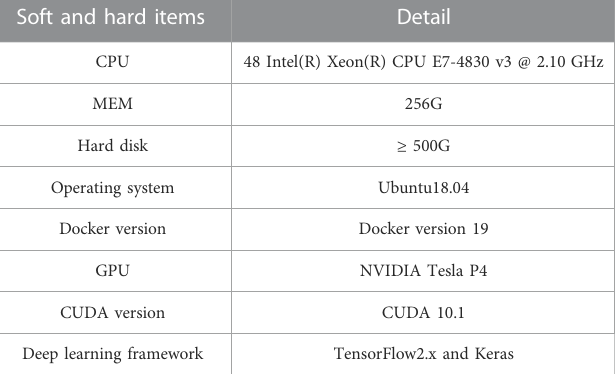
TABLE 2 Experimental environment. Soft and hard items